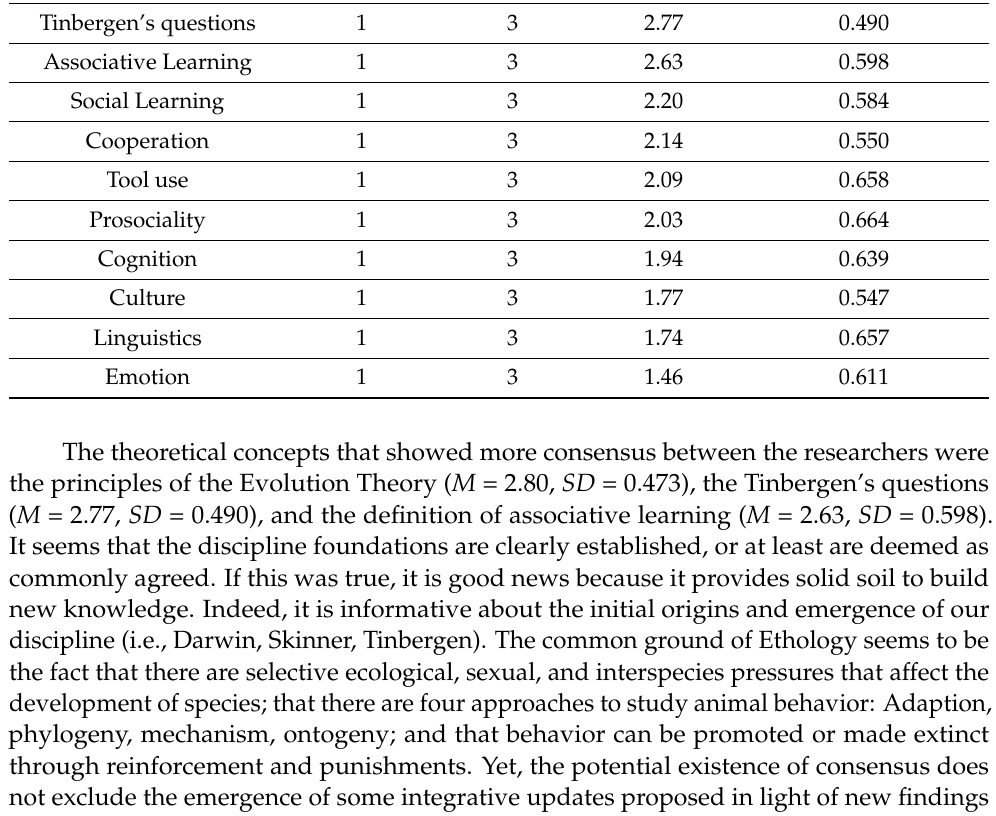
Table 2. Level of perceived consensus in eleven relevant concepts in Ethology (obtained from qualitative responses in a previous survey, N = 63). Concept Min. Max. Mean Standard Deviation Evolution Theory